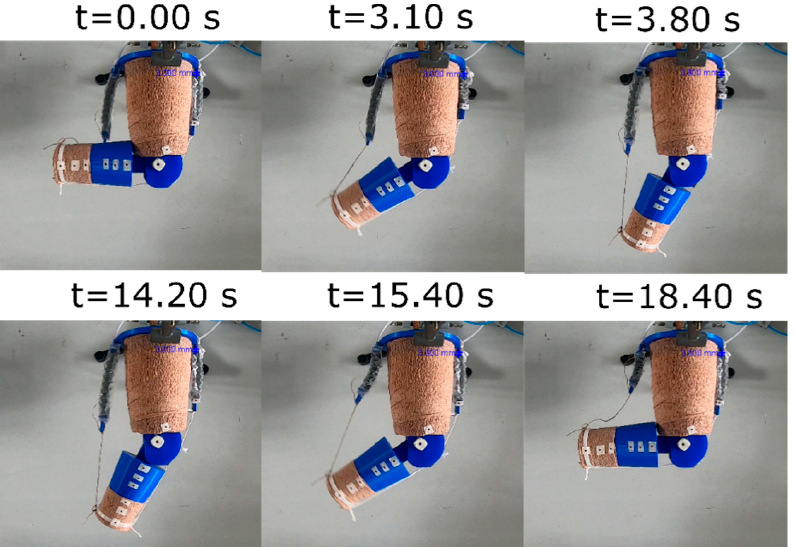
Figure 11. Time series images of infant leg model to exemplify rehabilitation exercise under extension (top three frames) and flexion (bottom three frames) as actuators are respectively contracted. Leg is fixed sideways to represent infant lying on their side, the direction of gravity being into the page.